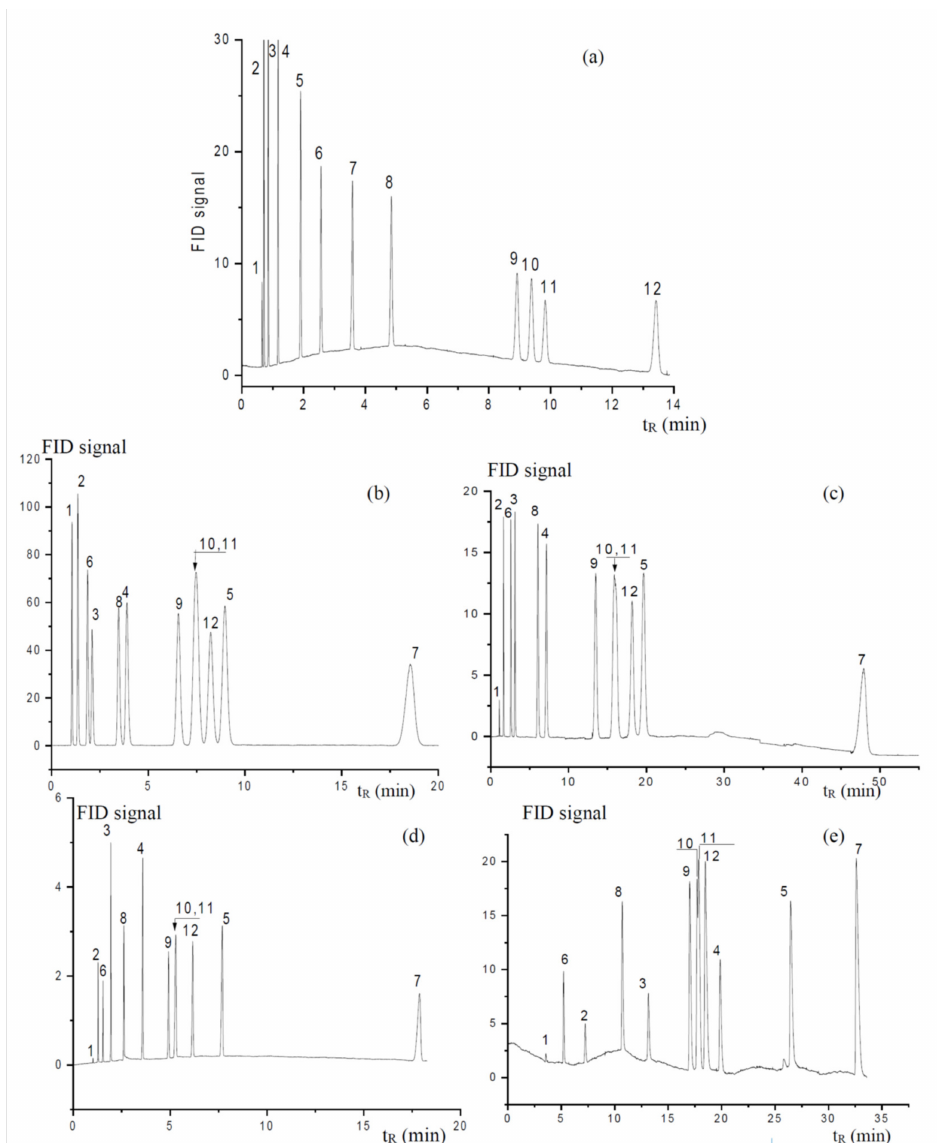
Figure 3. Separation of the test mixture during the investigated stationary phases: ( a )—PEG 20 M, ( b )—AP, ( c )—MP, ( d )—SE-30, ( e )—PTMSP. Test mixture: 1—n-pentane, 2—n-hexane,